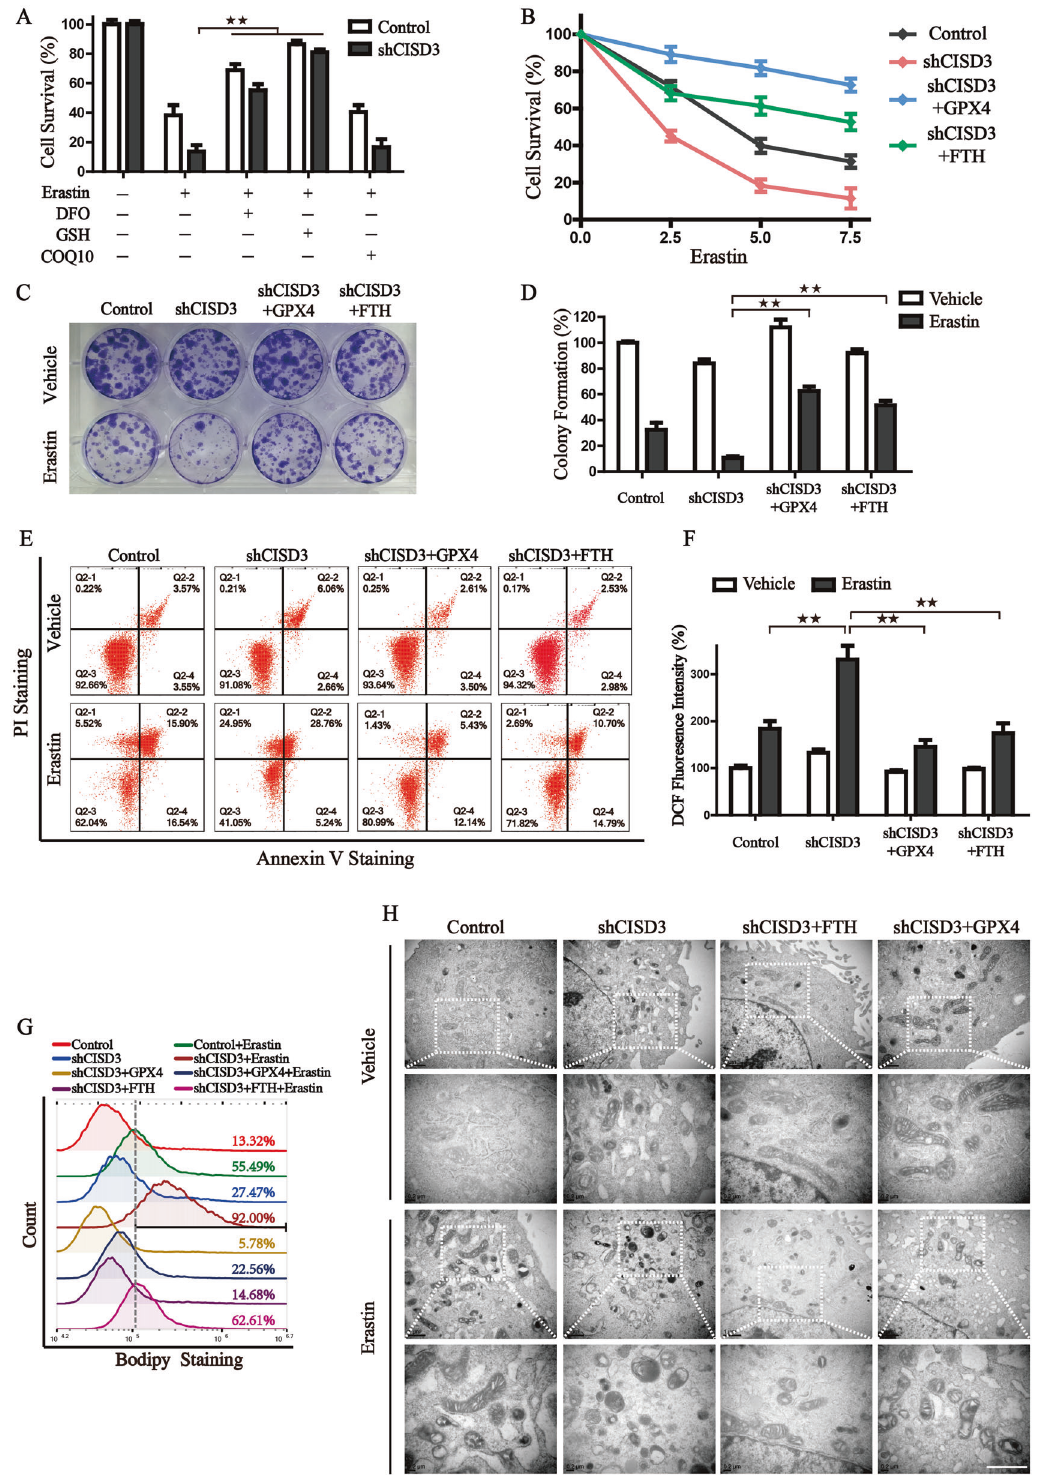
Fig. 7 Free iron accumulation is associated with ferroptosis derived from CISD3 knockdown. A Cell viability assay was monitored in shCISD3 and control cells by CCK8 kit in the presence or absence of indicated molecules (7.5 µM erastin, 100 µM DFO, 0.5 mM GSH, and 10 µM COQ10). B Cell viability of CISD3 silenced cells with or without GPX4 or FTH expression were measured at different concentrations of erastin treatment for 12 h. Long-term cell viability was detected by colony formation assay under the exposure of 0.5 µM erastin for 14 days ( C ), and corresponding histograms are shown on the right ( D ). Cell death ( E ), cellular ROS ( F ), and cellular lipid peroxides ( G ) were detected by fl ow cytometry in indicated cells with or without erastin treatment through Annexin V-PI, DCF-DA, and BODIPY C11 staining, respectively. H The morphological changes of mitochondria were detected by transmission electron microscopy in the absence or presence of 7.5 µM erastin. Lower scale bars: 1 μ m. * P < 0.05, ** P < 0.01 versus control or between different groups.